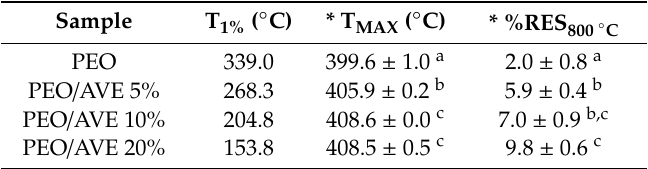
Table 1. Thermal decomposition parameters of PEO / AVE nanofibers.